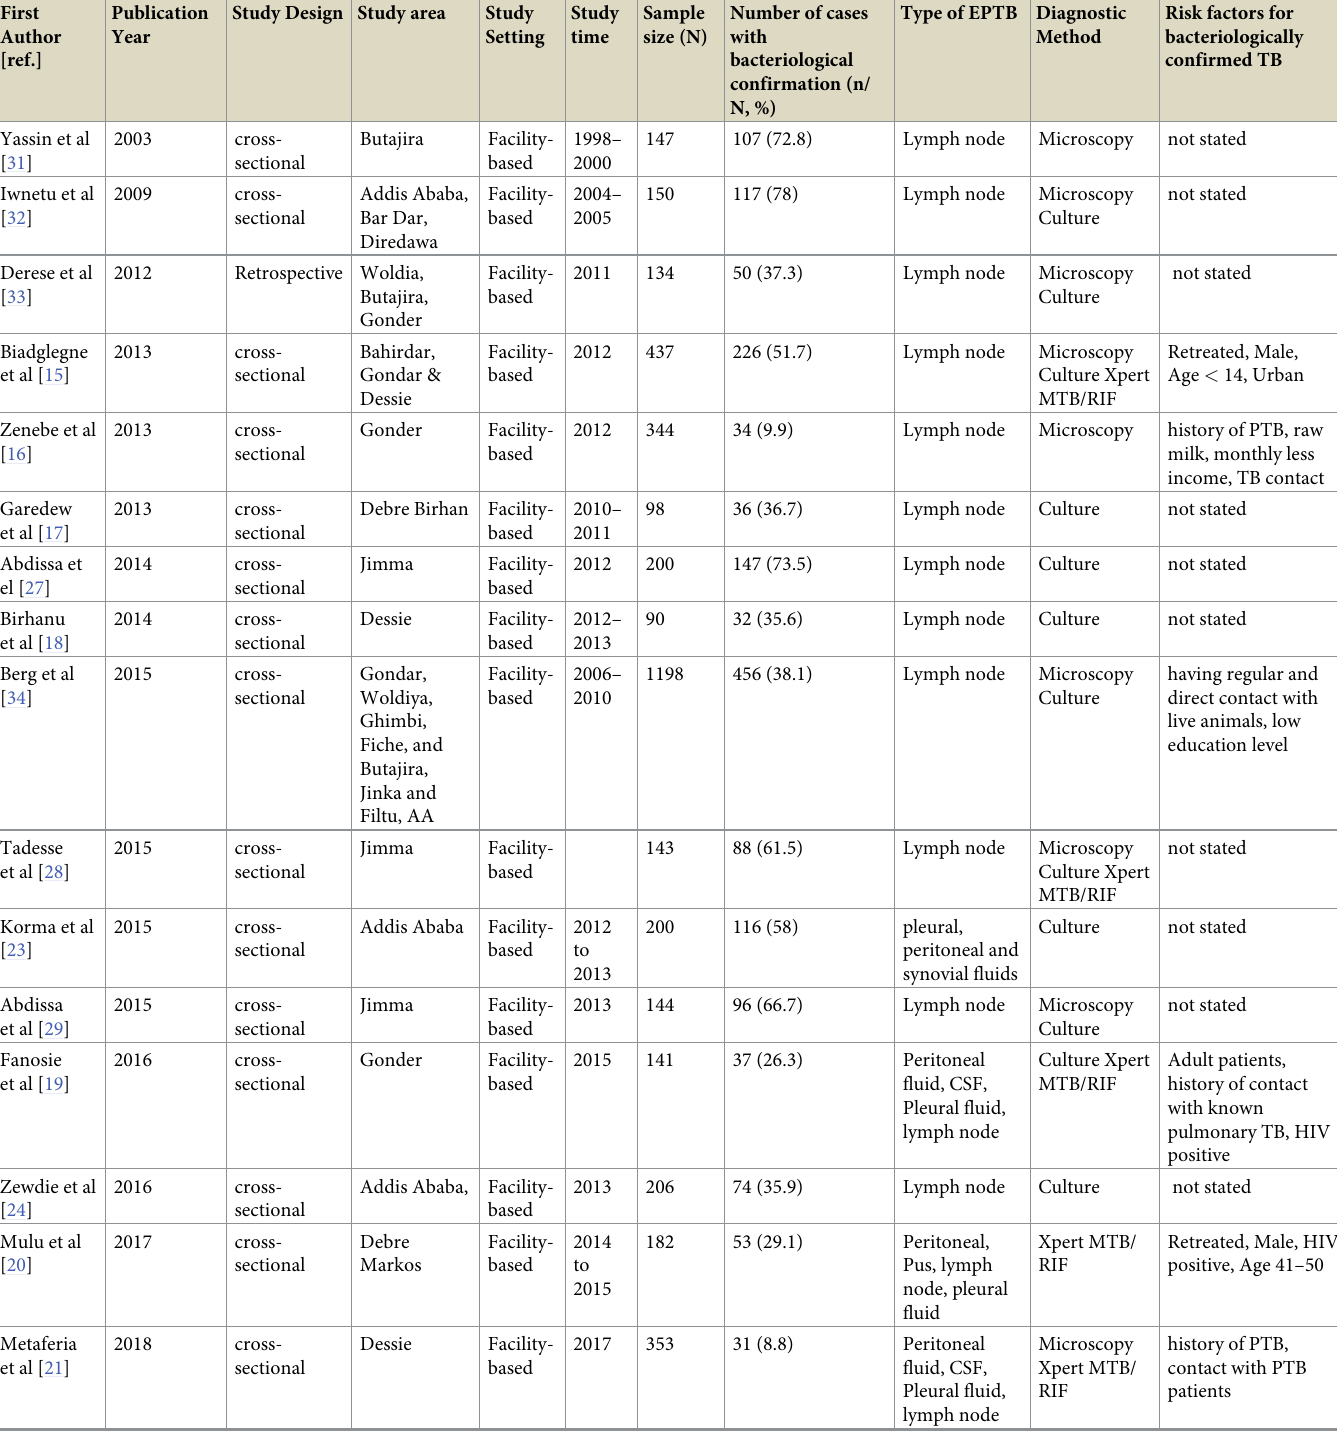
Table 1. General characteristics of studies describing extrapulmonary tuberculosis in